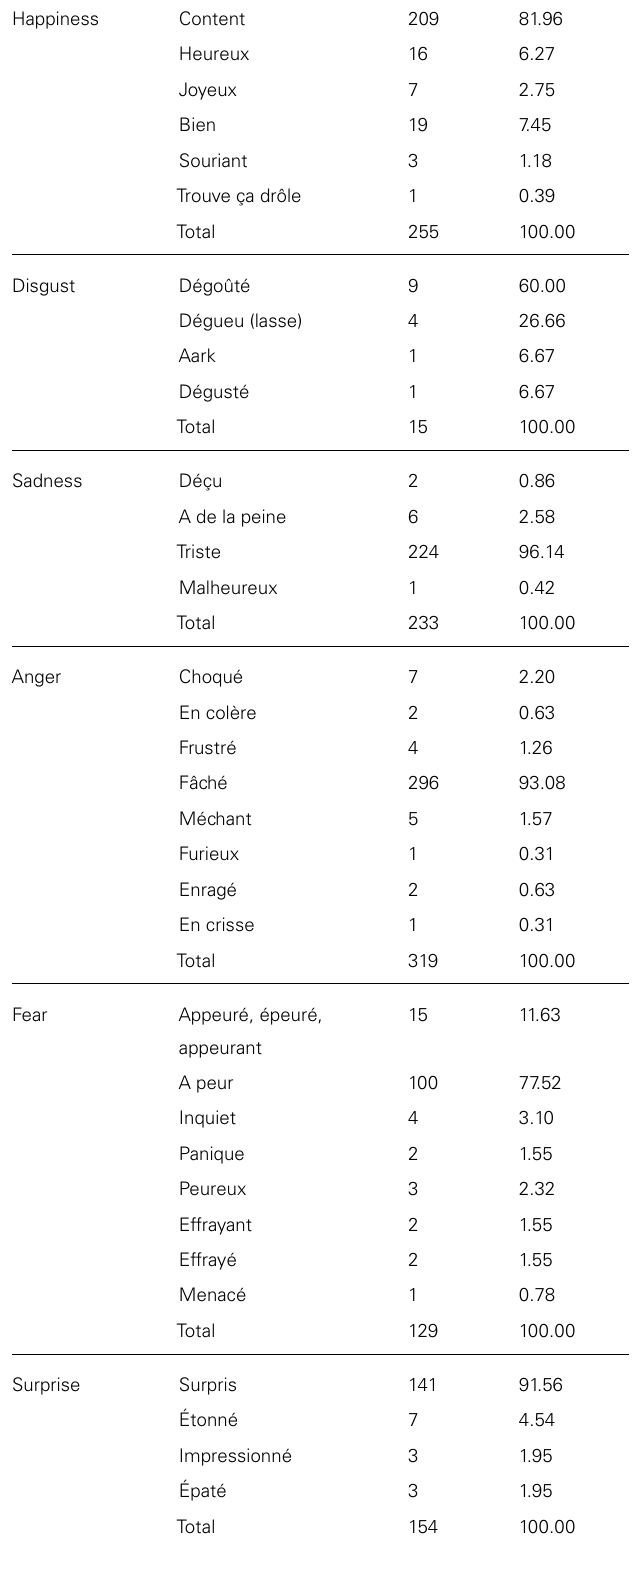
Table 4 | Frequency of the labels used by the participants for the overall